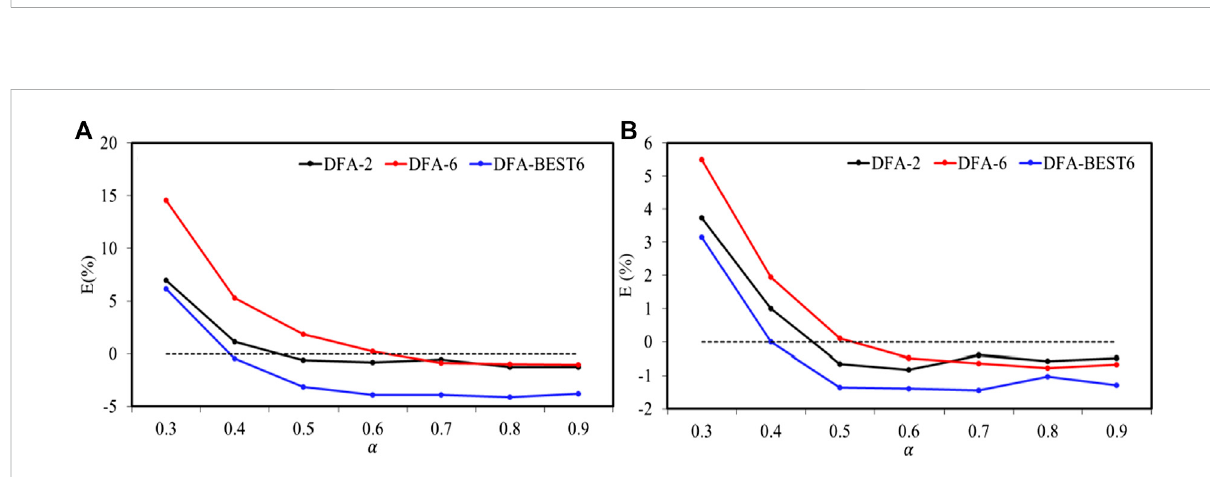
FIGURE 7 Relative error: the biases of the median of estimated exponents from the actual ones are shown for DFA-2, DFA-6 and DFA-BEST6 in (A) for 3,000 samples and in (B) for 20,000